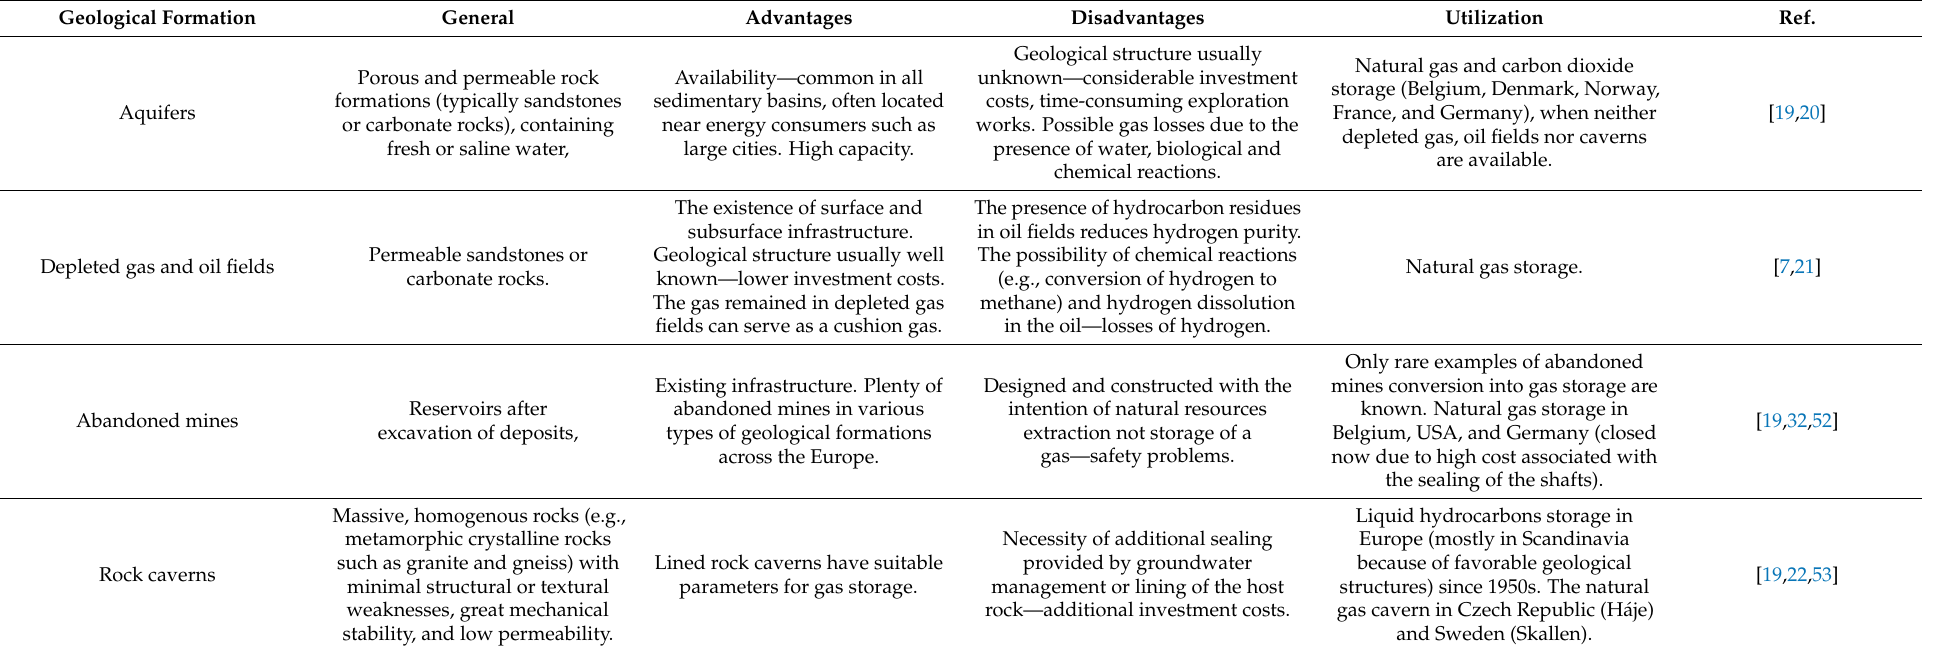
Table 4. The comparison of potential underground hydrogen storage